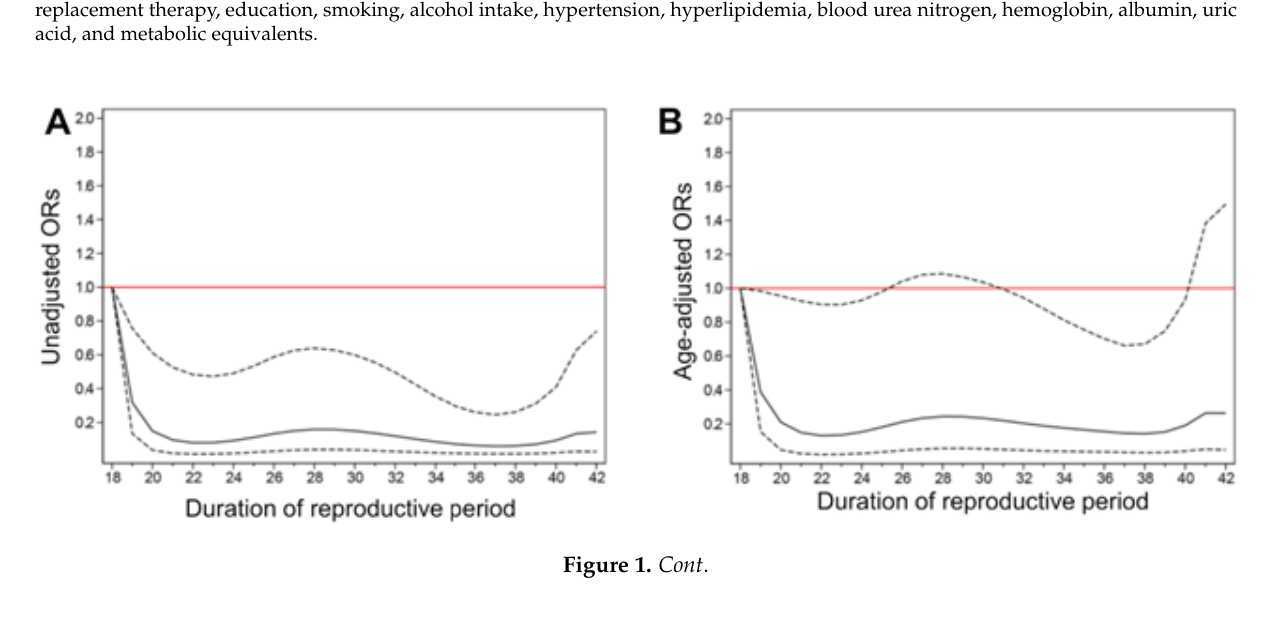
Figure 1. Odds ratios (ORs) (solid line) and 95% confidence intervals (dashed lines) of the reproductive period for esti- mated glomerular filtration rate (eGFR) < 60 mL/min/1.73 m 2 (reference: 18 years). ( A ) Unadjusted ORs; ( B ) Model 1: adjust for age; ( C ) Model 2: adjust for age, body mass index (BMI), parental history of chronic kidney disease, age at menarche, pregnancies, and hormone replacement therapy; ( D ) model 3: adjust for age, BMI, parental history of chronic kidney dis- ease, age at menarche, pregnancies, hormone replacement therapy, education, smoking, alcohol intake, hypertension, hy- perlipidemia, blood urea nitrogen, hemoglobin, albumin, uric acid, and metabolic equivalent. 3.4. Interaction between Reproductive Period and Physical Activity on Decreased Renal Function Table 3 and Figure 2 show the interaction effect of the length of the reproductive period and the amount of physical activity on developing eGFR < 60 mL/min/1.73 m 2 . After adjusting for demographic, metabolic, and reproductive factors, physical activity (quantified by MET) reduced the risk of developing eGFR < 60 mL/min/1.73 m 2 in those with a reproductive period of 37 – 45 years ( p = 0.010). The effect of physical activity on decreased eGFR by different lengths of the reproductive period is depicted in Figure 2: the log of the odds of developing eGFR < 60 mL/min/1.73 m 2 decreases with METs in women with a reproductive period of 35 – 40 years until 2500 METs, while it increases sharply with METs in women with a reproductive period of 20 – 30 years. Table 3. The interaction of reproductive period and metabolic equivalent on decreased renal func- tion.